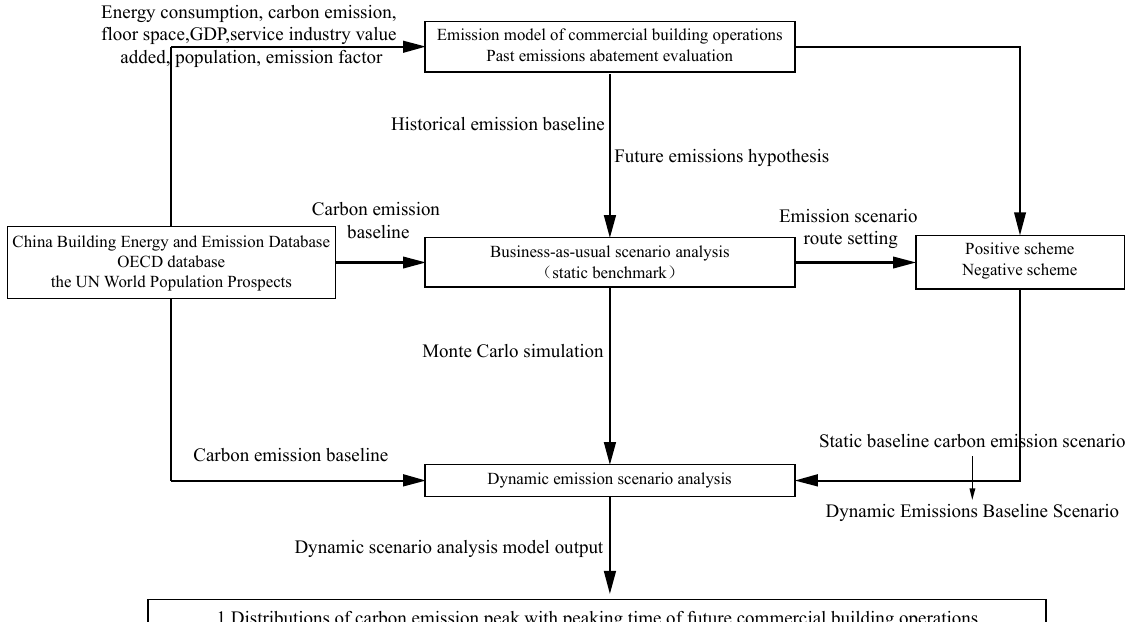
Figure 1. Flowchart of this study.